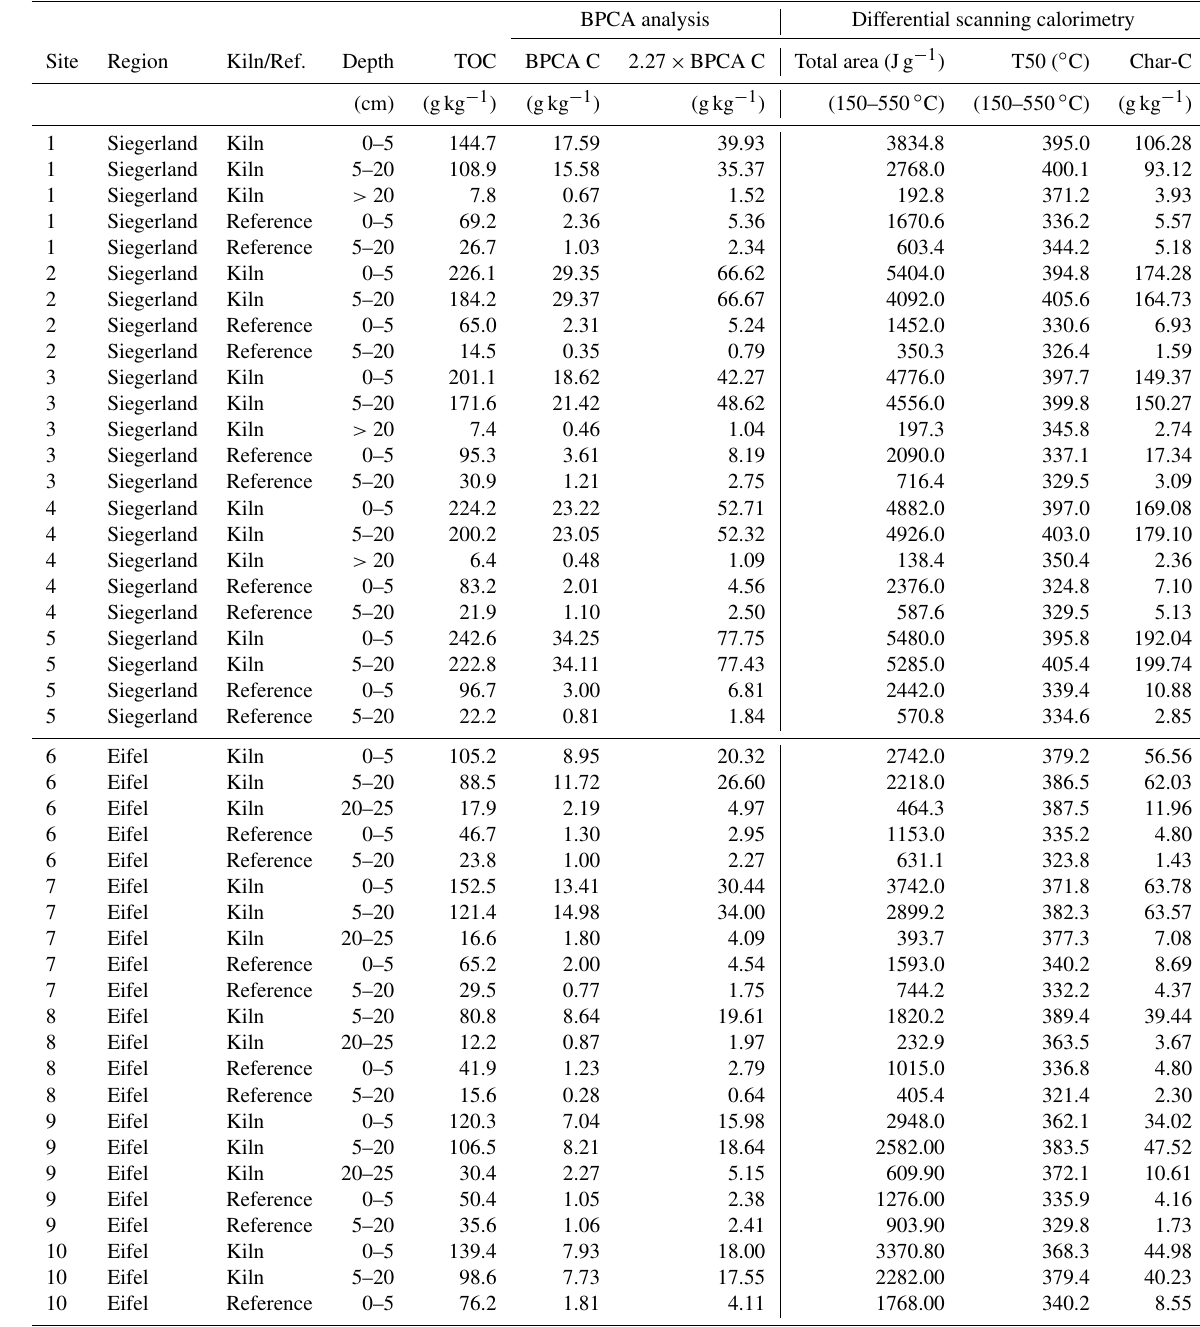
Table A1. TOC content, PLFA (phospholipid fatty acid) C content and DSC-derived charcoal-C content for the selection of 45 soil samples from